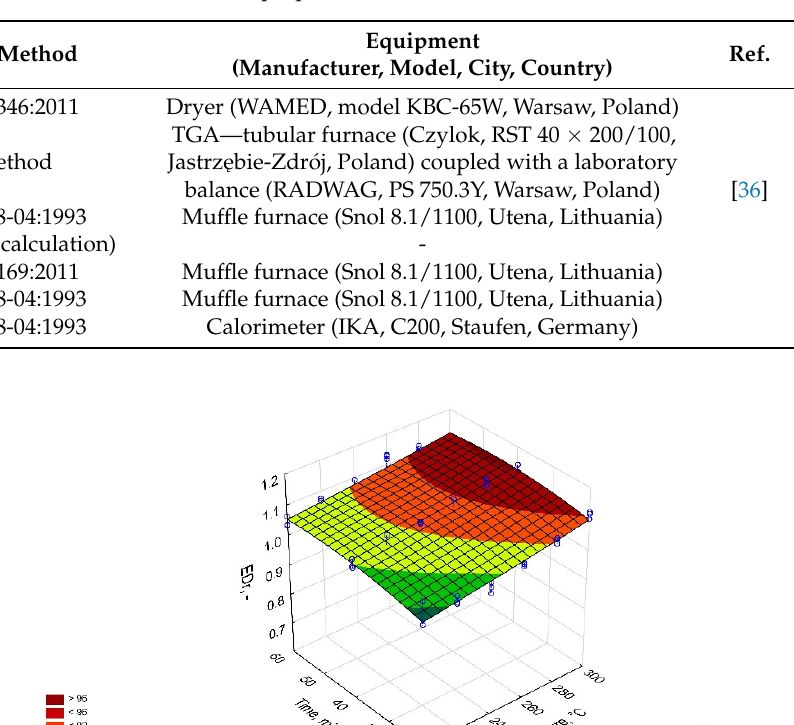
Table A1. Standards and methods used for fuel properties determination.